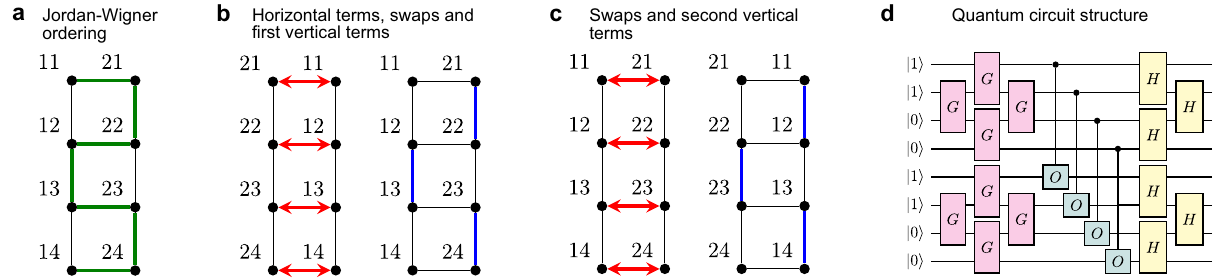
Fig. 1 | Implementation of the Ef fi cient Hamiltonian Variational ansatz. a Jordan-Wigner encoding mapping one spin sector of a 2×4 lattice to a line. Mapping is repeated for the other spin sector. b , c Horizontal terms are imple- mented combined with fermionic swaps (red); then the fi rst set of vertical terms (blue);thenanotherlayeroffermionicswaps;thenthesecondsetofverticalterms. d Quantum circuit structure shown for a 1×4 instance at half- fi lling with one